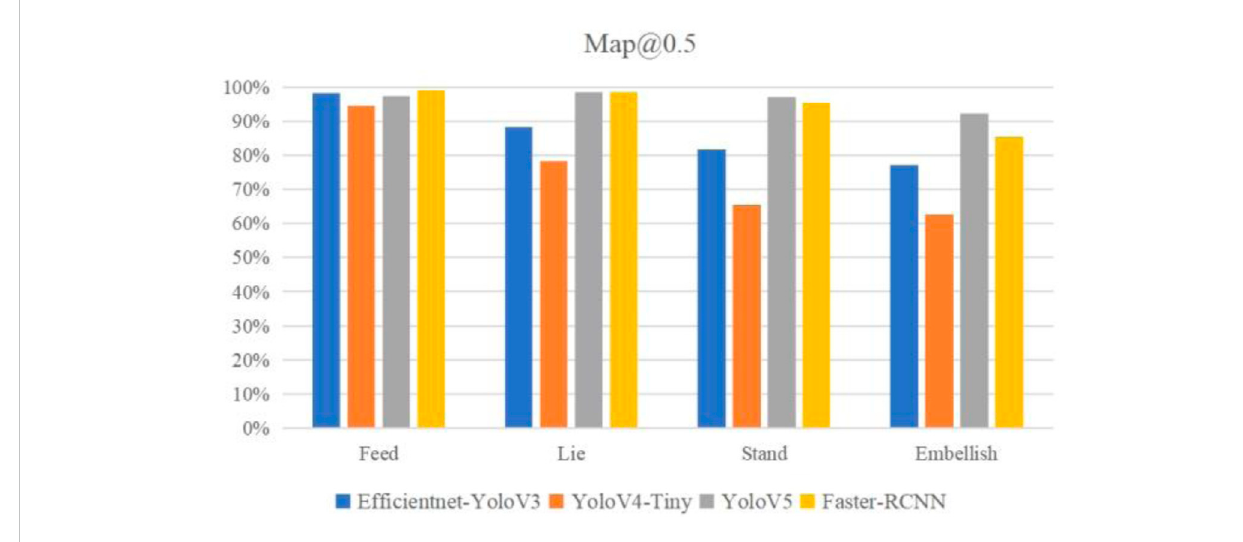
FIGURE 6 Map comparison diagram of different behaviors.